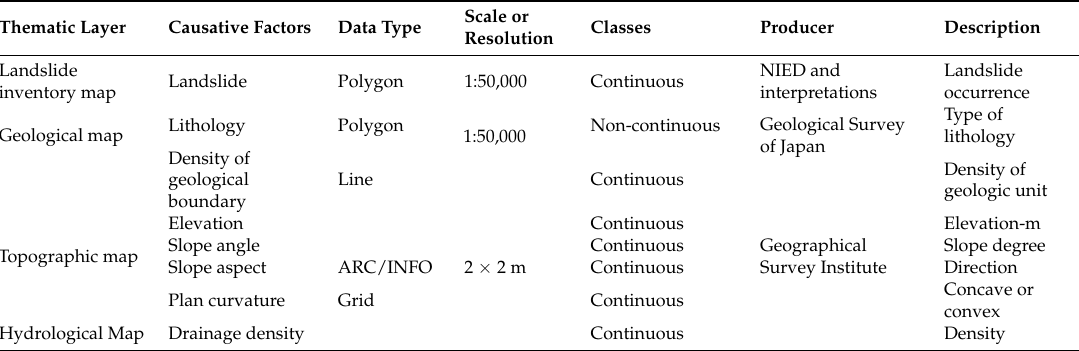
Table 1. Data collection in the study